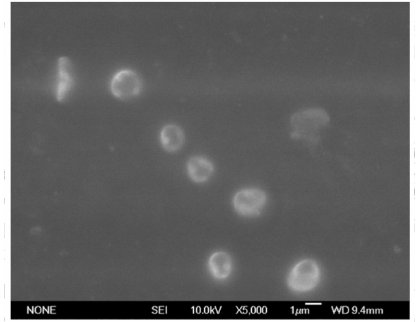
Figure 8. Scanning electron micrographs of iron oxide particles in the recharge